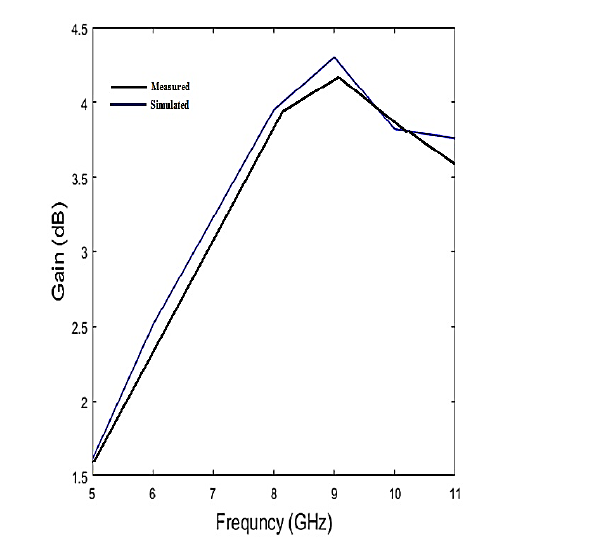
Figure 11 Simulated and measured gains versus